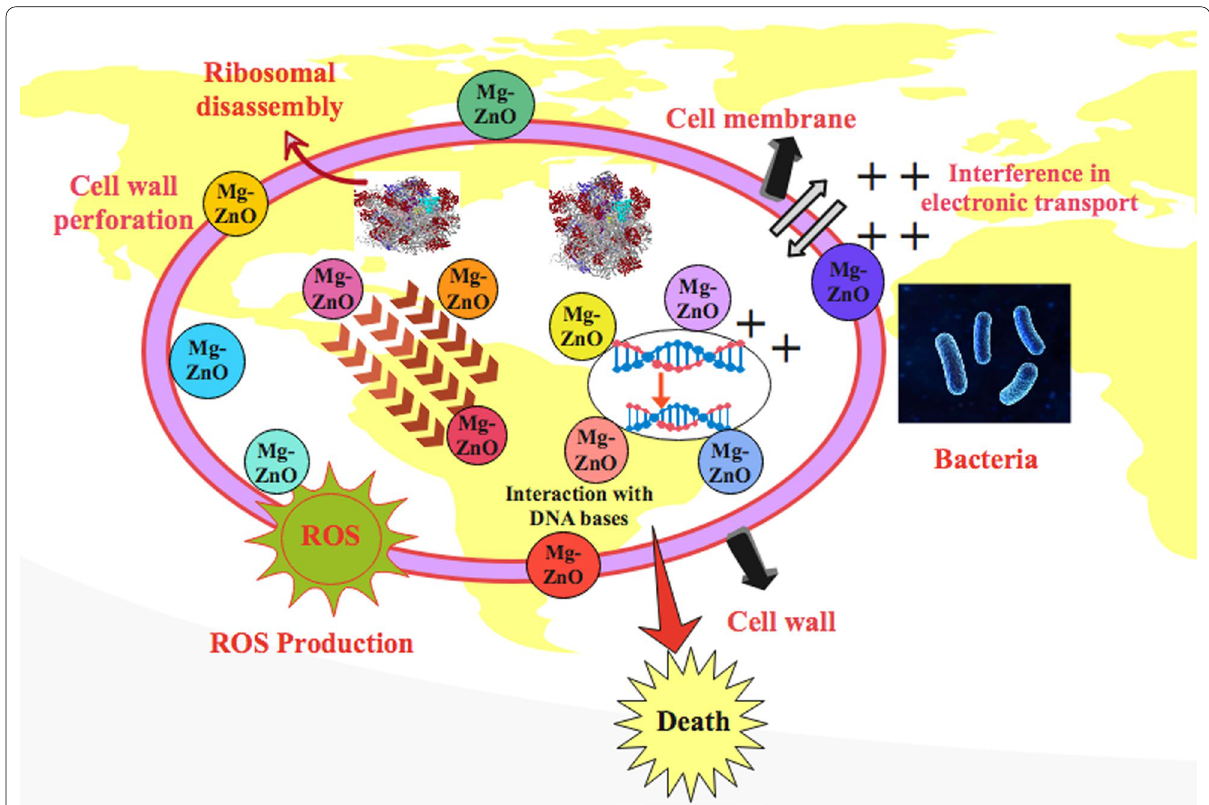
Fig. 10 Schematic illustration of bactericidal mechanism of Mg‑doped ZnO nanorods